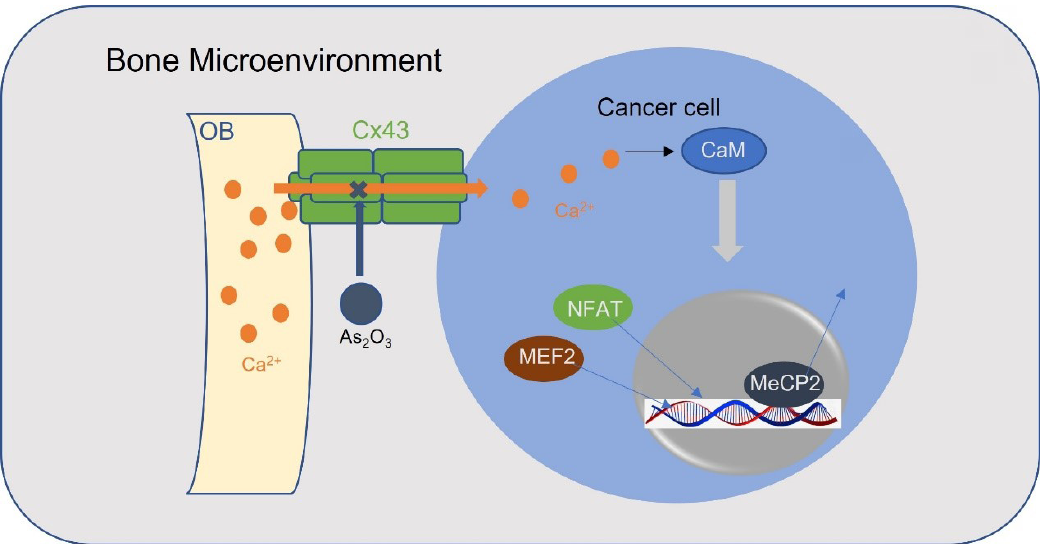
Figure 3. A schematic model for osteoblasts transports Ca 2+ ions into cancer cells through Cx43 gap junctions. Ca 2+ activates myocyte enhancer factor 2 (MEF2) and NFAT and releases methyl-CpG-binding protein 2 (MeCP2) from silenced promotors in a CaM-dependent manner. OB: